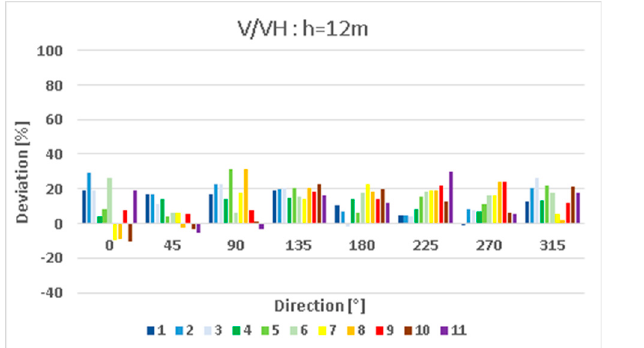
Figure 25. Mean absolute deviations of the wind ( a ) and turbulence intensity ( b ) per direction for